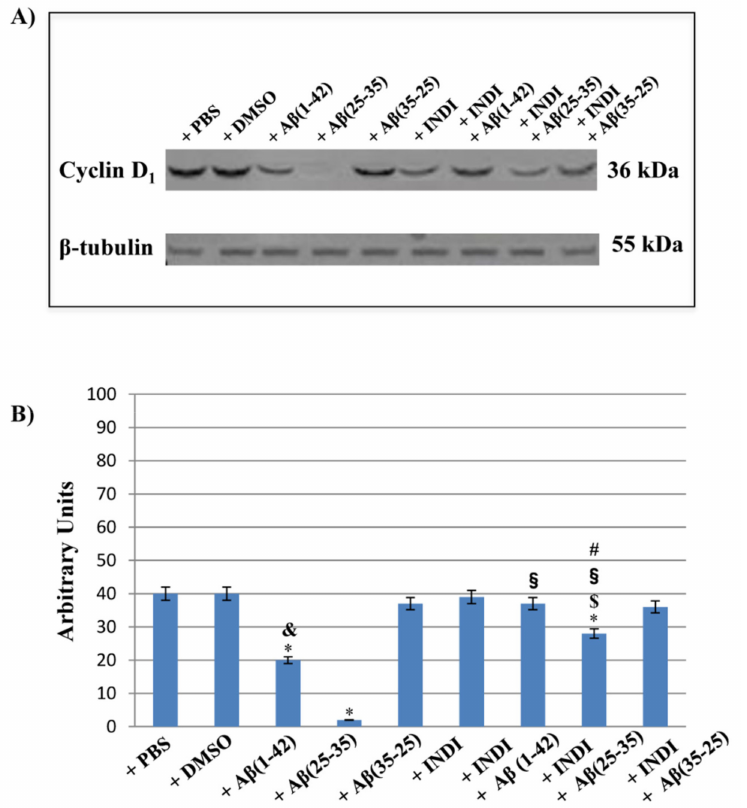
Figure 9. Western blotting analysis. ( A ) Representative immunoblot through western blotting analysis for cyclin D 1 expression levels in total cellular lysates from OECs in different conditions: control, DMSO, 100 µ M indicaxanthin, 10 µ M A β (1-42) or A β (25-35) or A β (35-25) both in the absence and presence of 100 µ M indicaxanthin for 24 h. ( B ) Densitometric analysis of cyclin D 1 expression levels performed after normalization with β -tubulin. The results are expressed as the mean ± S.D. of the values of five separate experiments performed in triplicate. * p < 0.05 significant differences vs. controls. $ p < 0.05 significant differences of A β (1-42) + INDI or A β (25-35) + INDI or A β (35-25) + INDI vs. INDI; § p < 0.05 significant differences of A β (1-42) + INDI vs. A β (1-42), A β (25-35) + INDI vs. A β (25-35) or A β (35-25) + INDI vs. A β (35-25); & p < 0.05 significant differences of A β (1-42) vs. A β (25-35 ) or vs. A β (35-25); # p < 0.05 significant differences of A β (25-35) + INDI vs. A β (1-42) + INDI or vs. A β (35-25) +